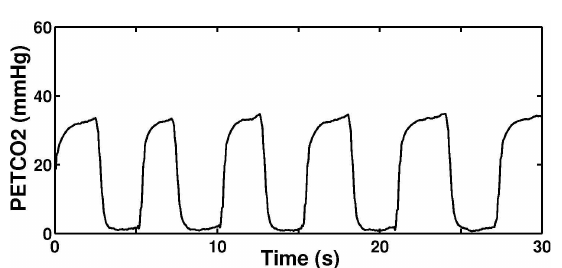
Figure 15. Respiratory CO